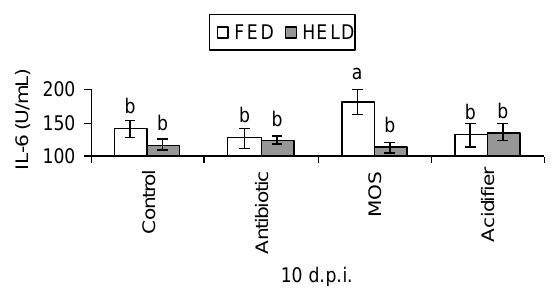
Figure 1. Effects of post hatch holding time and dietary supplements on Chicken IL-6 production 10 days post infection (d.p.i.) (Mean values, n = 6; error bars indicate SEM; bars without a common superscript differ